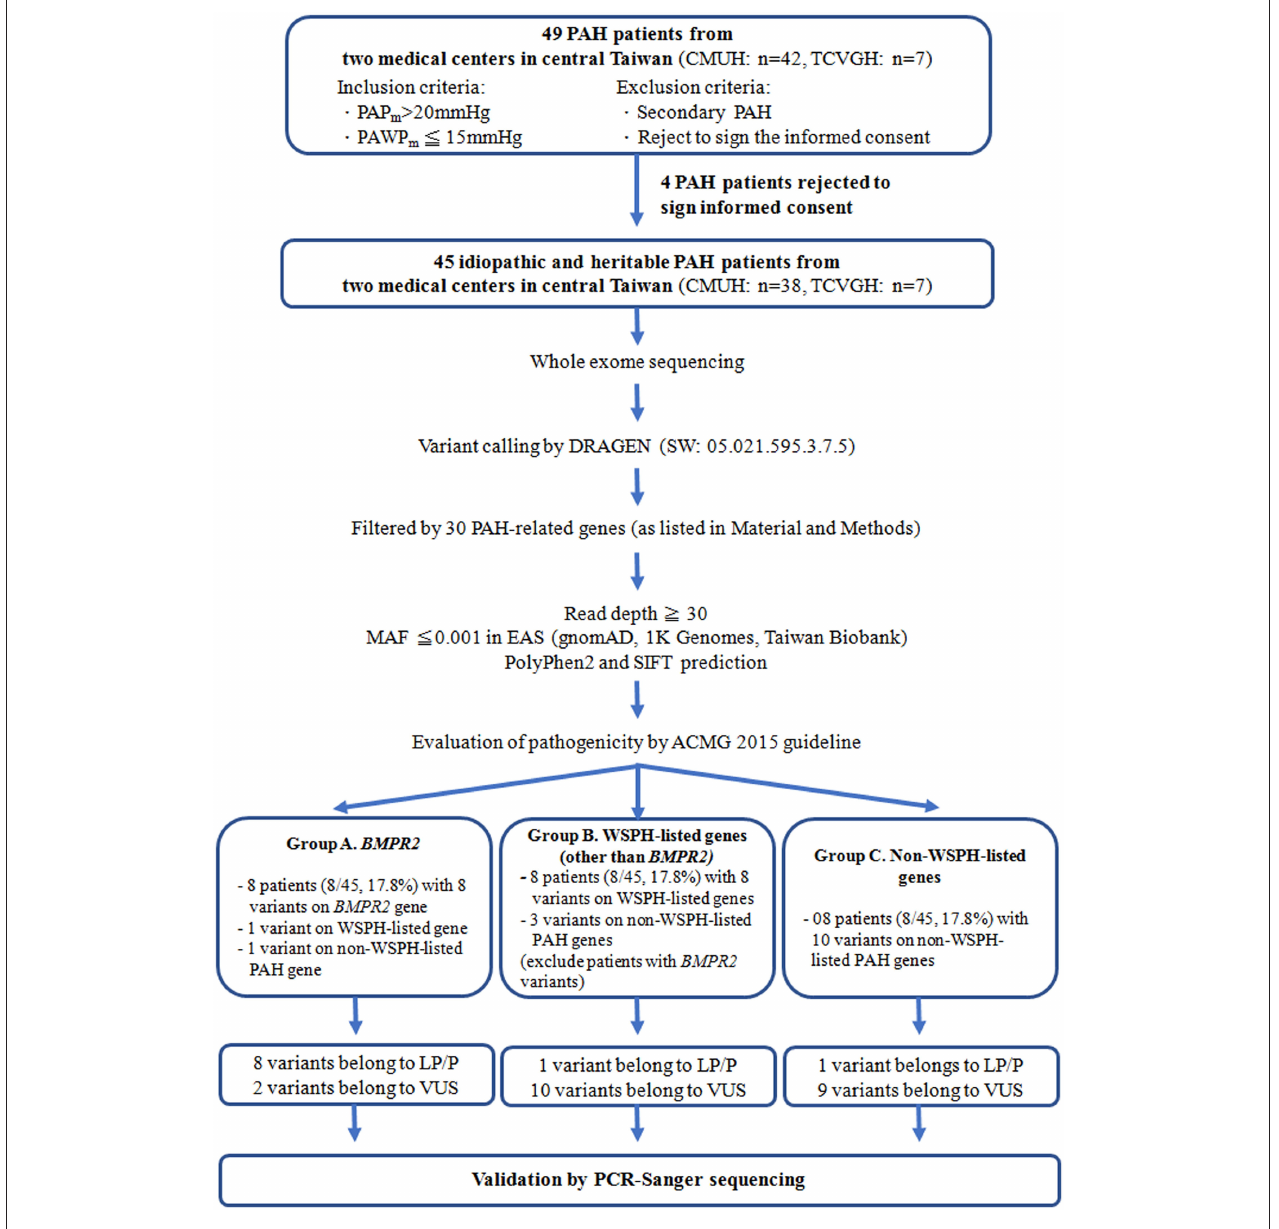
FIGURE 1 | The study flow chart. PAH, pulmonary arterial hypertension; WSPH, The 6th World Symposium on Pulmonary Hypertension; BMPR2 , bone morphogenetic protein receptor type-2; TCVGH, Taichung Veterans General Hospital (Taichung, Taiwan); CMUH, China Medical University Hospital (Taichung, Taiwan); ACMG, 2015 The American College of Medical Genetics and Genomics guidelines; P, pathogenic; LP, likely pathogenic; VUS, variant of uncertain significance; MAF, Minor allele frequency of East Asian, PAP m , mean pulmonary arterial pressure, PAWP m , mean pulmonary arterial wedge pressure; PCR, polymerase chain reaction.